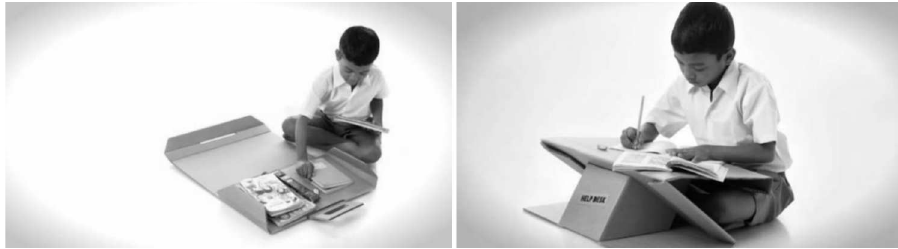
Figure 4. Help Desk – a cardboard desk for the